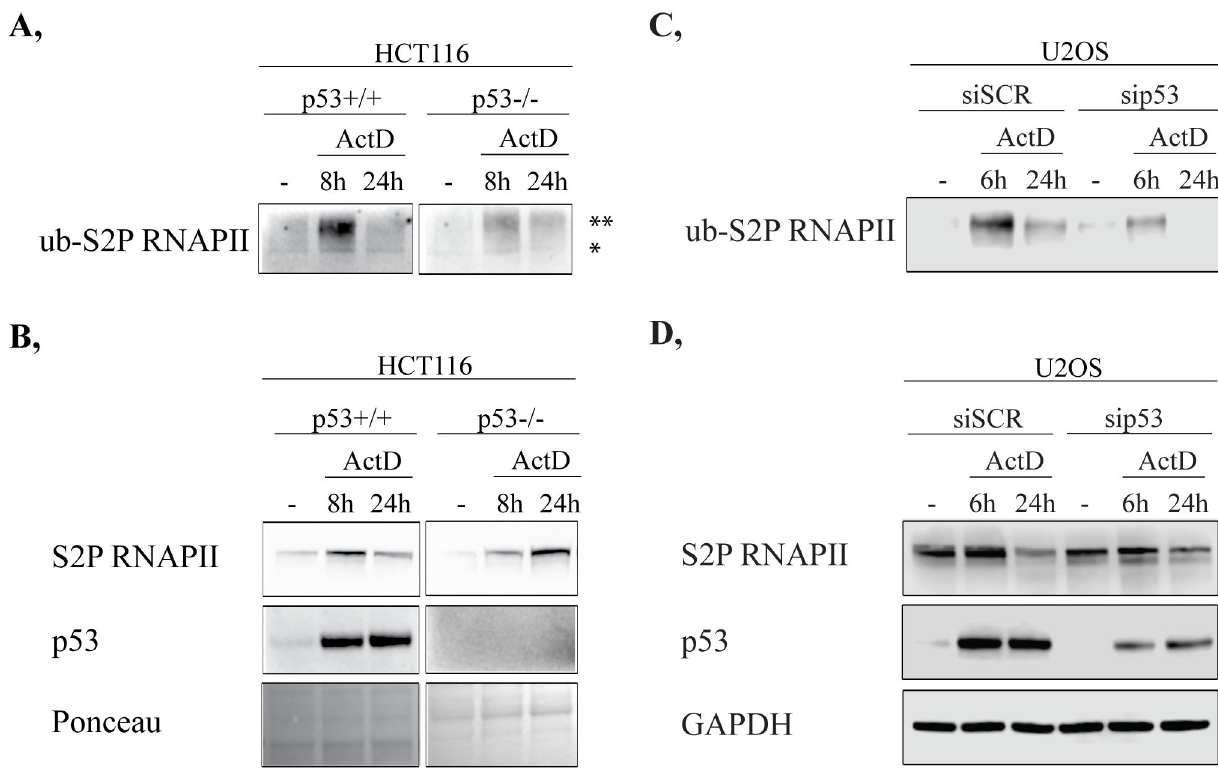
Fig 2. p53 involvement in the ubiquitylation of RNAPII following ActD treatment is a ubiquitous process. ( A ) Tandem ubiquitin-binding entities (TUBEs) pull-down followed by Western blot detection was performed in HCT116 p53+/+ (left panel) and p53-/- (right panel) cells. TUBEs experiment was accomplished under physiological conditions as well as 8 h and 24 h following ActD treatments. From the pulled-down ubiquitylated protein pool, polyubiquitylated S2P RNAPII (ub-S2P RNAPII) was detected with anti-S2P RNAPII antibody. � : monoubiquitylated S2P RNAPII, �� : polyubiquitylated S2P RNAPII ( B ) Western blot experiment on whole cell lysates of HCT116 p53+/+ (left panel) and p53-/- (right panel), which were used for TUBEs pull- down assay. Total protein level changes of S2P RNAPII and p53 following 8 h and 24 h ActD treatments were immunodetected using specific antibodies. Ponceau staining was applied to detect the equal loading of the input samples. ( C ) Tandem ubiquitin-binding entities (TUBEs) pull-down followed by Western blot detection was performed in non-targeting and p53 silencing siRNA-transfected (referred to as siSCR and sip53, respectively) U2OS cells. In U2OS cells, TUBEs assay was performed under physiological conditions, 6 h and 24 h following ActD treatments. From the pulled-down ubiquitylated protein pool, polyubiquitylated S2P RNAPII (ub-S2P RNAPII) was detected with anti-S2P RNAPII antibody. ( D ) Western blot experiment on whole cell lysates of U2OS cells which were used for TUBEs pull-down assay. Total protein level changes of S2P RNAPII and p53 as a response to 6 h and 24 h ActD treatments were immunodetected using specific antibodies. GAPDH detection was applied to detect the equal loading of the input